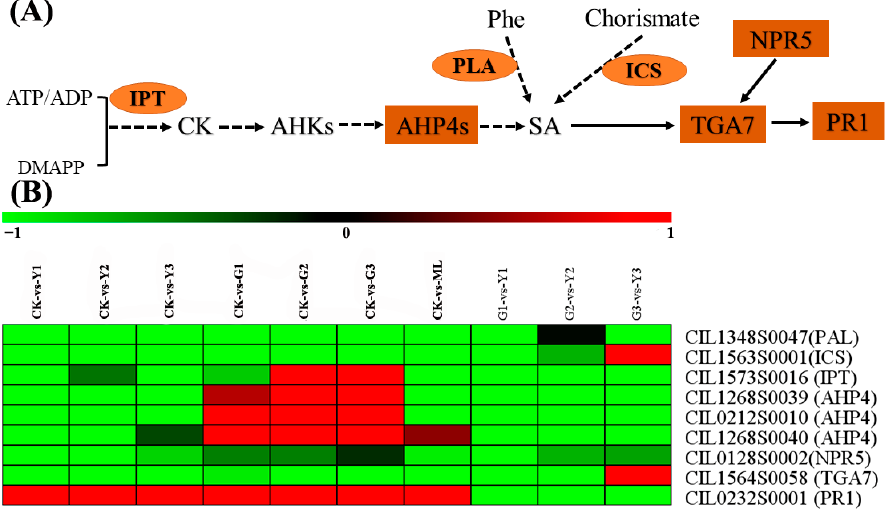
Figure 10. Model of cytokinin and SA action in response to PMV infection ( A ) and DEGs ( B ). Heat maps were drawn using the Log2 ratio. Detailed genes and expressions data are provided in Table S15, available as Supplementary Data online. PAL, phenylalanine ammonia-lyase; Phe, phenylalanine; ICS, isochorismate synthase; ATP/ADP, adenosine 5 ′ -phosphates; DMAPP, dimethylallyl diphosphate; AHK, histidine kinase; AHP, histidine-containing phosphotransfer protein; SA, salicylic acid; TGA7, transcription factor TGA7; NPR5, non-expressor of PR gene 5; PR1, pathogenesis-related protein 1; IPT, adenylate isopentenyltransferase. The heat maps indicated the upregulation (red) and downregulation (green) of genes in PMV-infected samples compared to CK. 2.9. DEGs of Fatty Acid Biosynthesis, Elongation, and Degradation Pathways Fatty acid biosynthesis (Ko00061), elongation (Ko00062), and metabolism (Ko01212) pathways were detected through KEGG analysis (Figure 4). A total of 17 DEGs of fatty acid biosynthesis were altered significantly in PMV-infected samples compared to CK, and 15 genes were downregulated, including genes coded acetyl-CoA carboxylase 1 (ACC1), 3-oxoacyl-acyl-carrier-protein synthase (KAS), stearoyl-acyl-carrier-protein 9- desaturase (SSI2, ACPD), and so on. A total of 24 DEGs of fatty acid elongation were changed significantly, and 17 genes were downregulated, including eight genes coded 3- ketoacyl-CoA synthase (KCSs, FDH, and CUTs), two genes coded very-long-chain 3- oxoacyl-CoA reductase (KCR) and a very-long-chain enoyl-CoA reductase (ECR) (Figure 11 and Table S18). Moreover, many MYB transcription factors were detected, and most of these genes were downregulated (Figure 11 and Table S12). These results showed that the fatty acid and very-long-chain fatty acids (VLCFAs) biosynthesis were blocked in PMV- infected pecan plants. 2.10. DEGs Involved in Starch and Sucrose Metabolism Pathway To predict important candidate genes for carbohydrate metabolism under PMV attack conditions, we screened PMV-responsive genes for those encoding enzymes involved with starch biosynthesis and degradation, sucrose metabolism. The abundance of several of the transcripts encoding starch biosynthesis and degradation enzymes was elevated in pecan plants after exposure to PMV attack (Figure 12 and Table S19). The genes encoding glucose-1-phosphate adenylyltransferase (GLGC) were downregulated in PMV- infected pecan plants. The transcripts level of genes encoding the granule-bound starch synthase (WAXYs) was downregulated in yellow levels of PMV-infected pecan plants, especially in the Y3 sample. In particular, the levels of three alpha-amylase transcripts